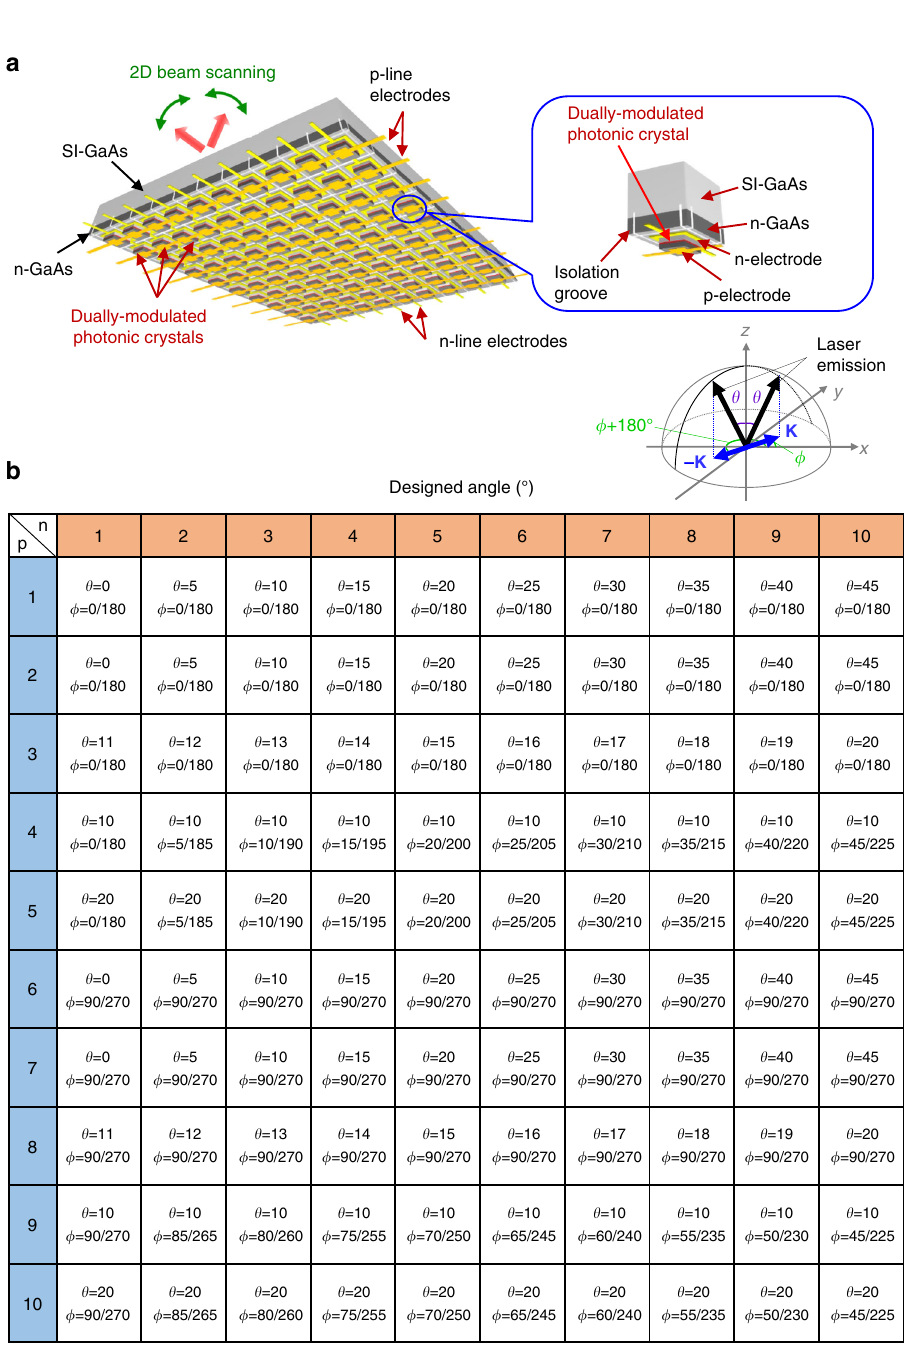
with fi xed azimuthal angles ϕ ¼ 90 (cid:4) = 270 (cid:4) by driving one p-line electrode (p-6) and switching the n-line electrodes (from n-1 to n- 10). The third row of Fig. 6b shows parallel 2D beam scanning, where we realize the simultaneous scanning of both polar angles (from θ ¼ 0 (cid:4) to 45 (cid:4) ) and azimuthal angles (from ϕ ¼ 0 (cid:4) = 180 (cid:4) to 45 (cid:4) = 225 (cid:4) ). A video of 2D beam scanning performed in real time, for not only the range of angles displayed in Fig. 6, but also various other angles with single and parallel operation, is provided as a Supplementary Movie 1 and is described in Supplementary Note 6.